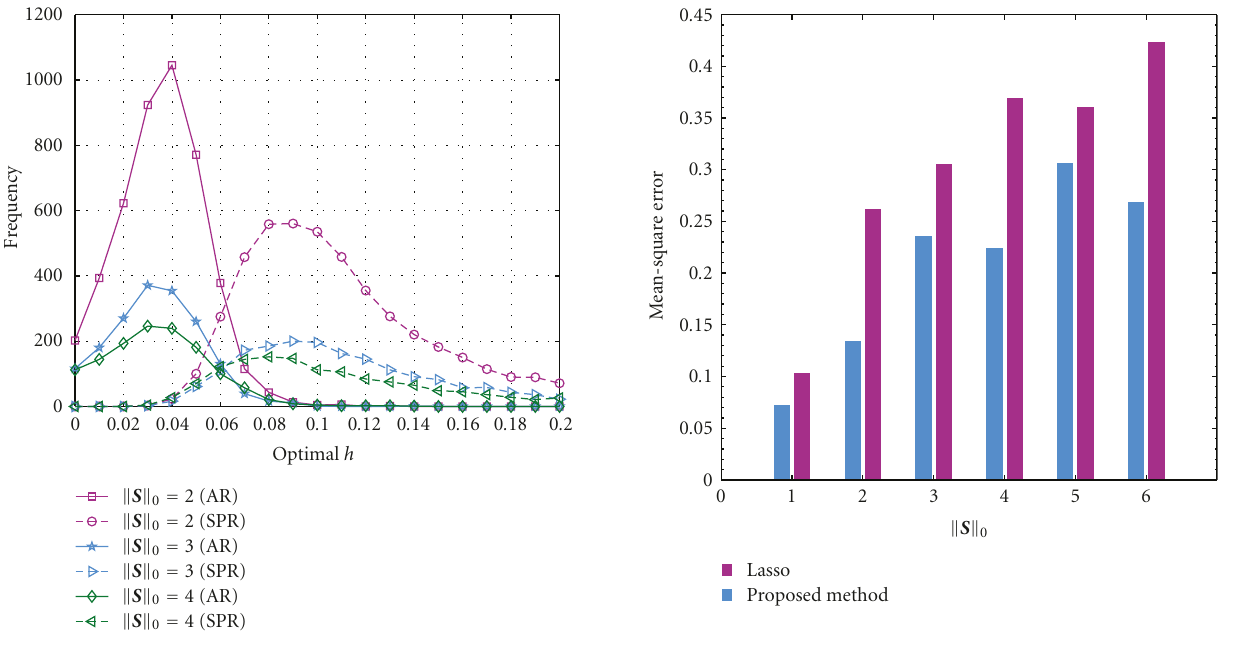
Figure 3: Comparison on the mean-square error. error between the true sparse vector S and the solutions (cid:2) S obtained from the proposed method, Lasso, and BPDN [11]. The parameters used in this experiment are n = 10, m = 30, (cid:3) S (cid:3) 0 = 1,2,3 ... ,6, and (cid:3) e (cid:3) 2 ≤ 0 . 1. The